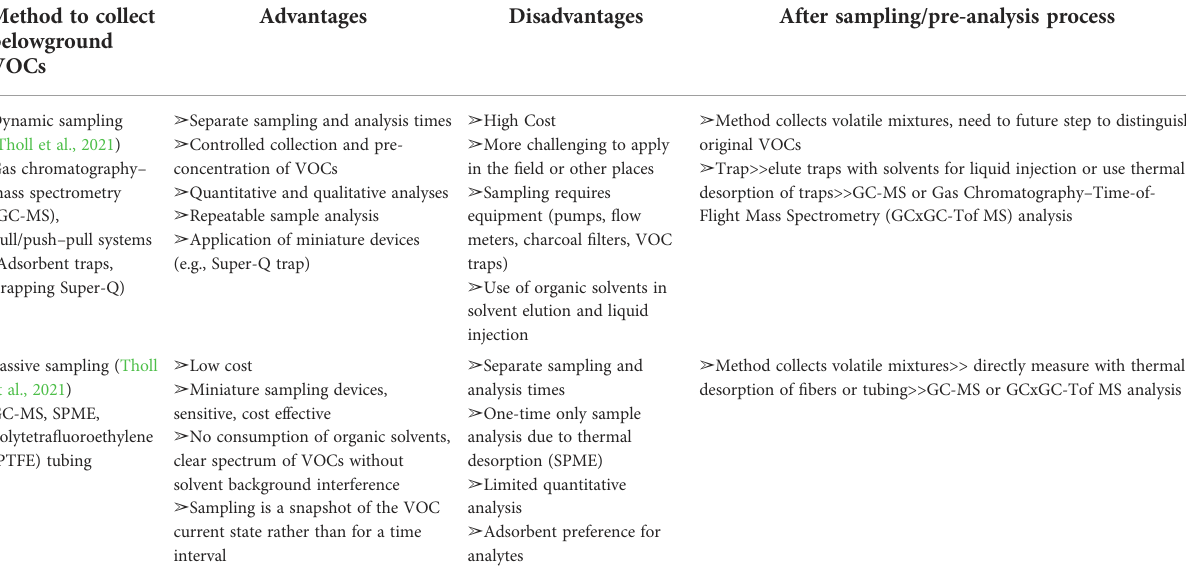
TABLE 3 Advantages and disadvantages of dynamic and passive methods to collect volatile organic compounds (VOCs) in belowground environments. Method to collect Advantages Disadvantages After sampling/pre-analysis belowground VOCs